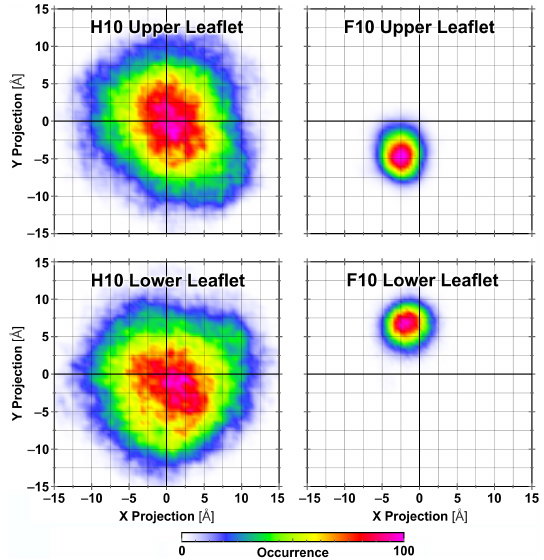
Figure 6. Projection of the dipalmitoylphosphatidylcholine (DPPC) chain tilting vectors (from α - to ω -carbon atom of carboxylic acids) into the X–Y plane for the H10 ( left ) and F10 ( right ) systems during the last 5 ns of the trajectories. Collective tail tilting (as on the right side) indicates gel phase [31]. Table 2. Self-diffusion coefficients of dipalmitoylphosphatidylcholine (DPPC) and additive molecules (assuming 2D diffusion; all simulations performed at 323K and with 6:1 mixing ratio unless